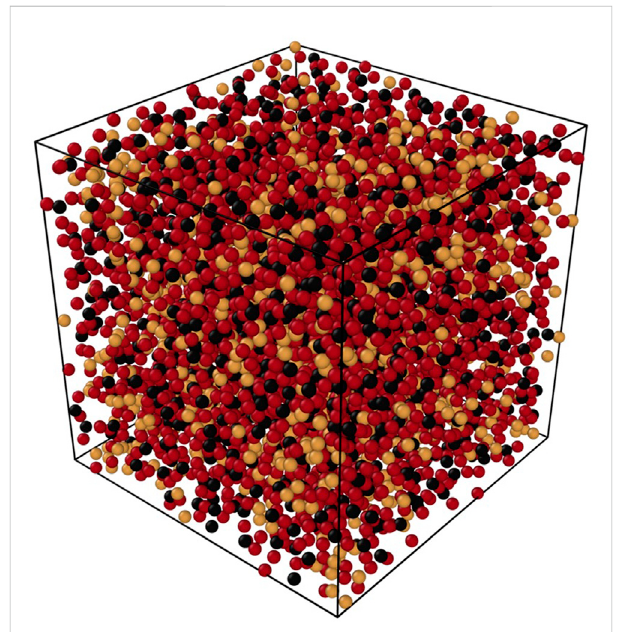
FIGURE 1 Example of the resulting glass made using the methodology described in this work, with 5100 atoms of lithium (yellow), oxygen (red), and silicon (black) at the right proportions to give a composition of 0.30 Li 2 O 0.70 SiO 2